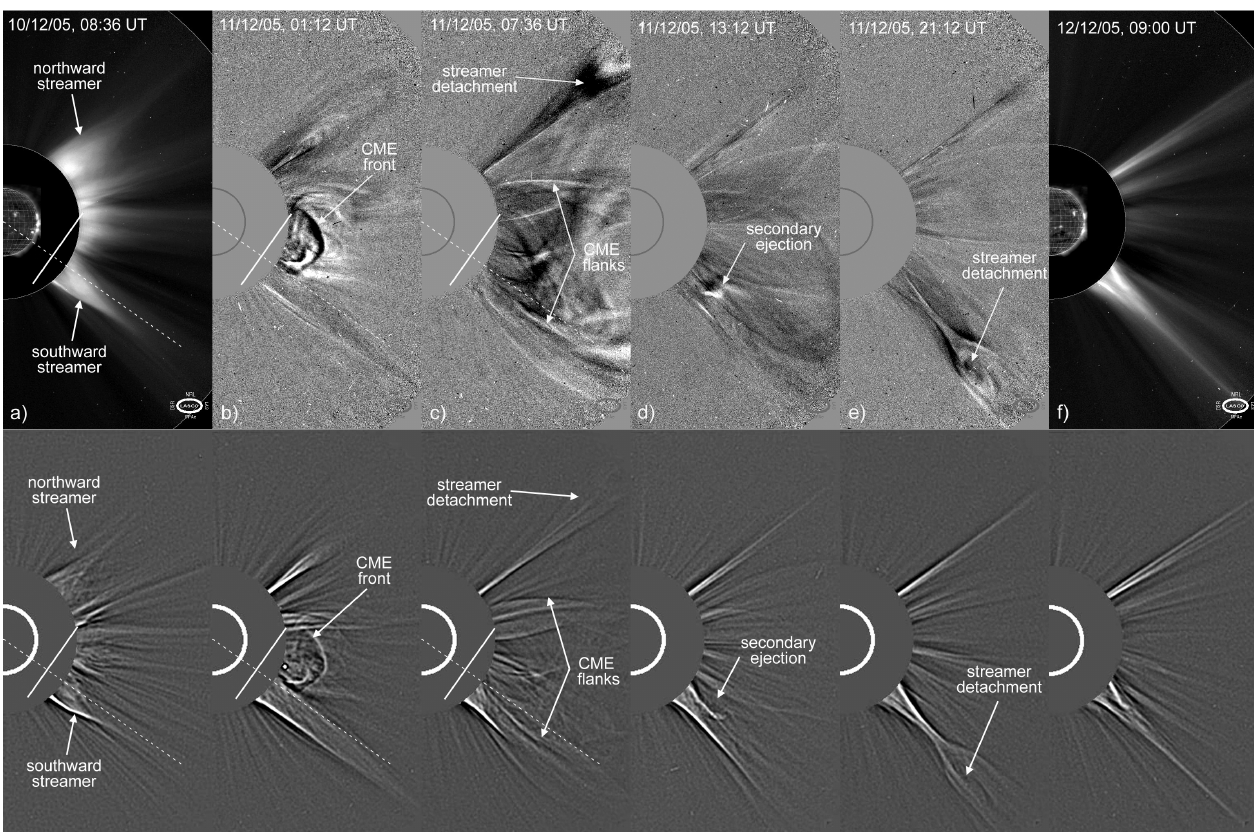
Fig. 1. The white light solar corona as seen by the LASCO/C2 coronagraph in standard (top row, panels a and f ), running difference (panels b–e ) and wavelet (bottom row) images. This sequence shows the observed occurrence of secondary eruptions associated with the main CME of 11 December